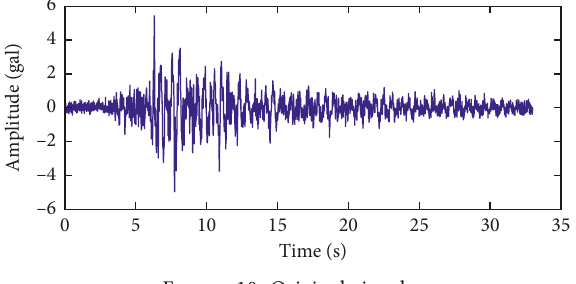
Figure 10: Original signal.